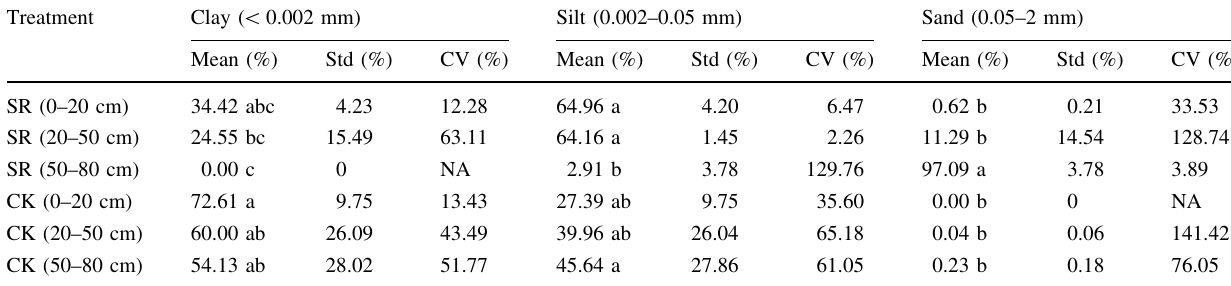
Table 1 Particle size distribution of the reclaimed and unaltered farmlands according to the USDA system